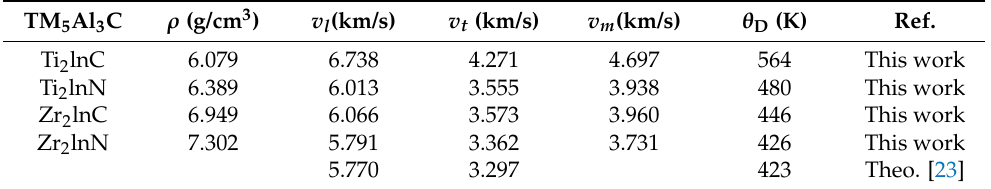
Table 6. The density ρ , sound velocities (longitudinal ν l , transverse ν t , and mean ν m ), and Debye temperature θ D of M 2 InX (M = Ti, Zr and X = C, N) MAX phases. TM 5 Al 3 C ρ (g/cm 3